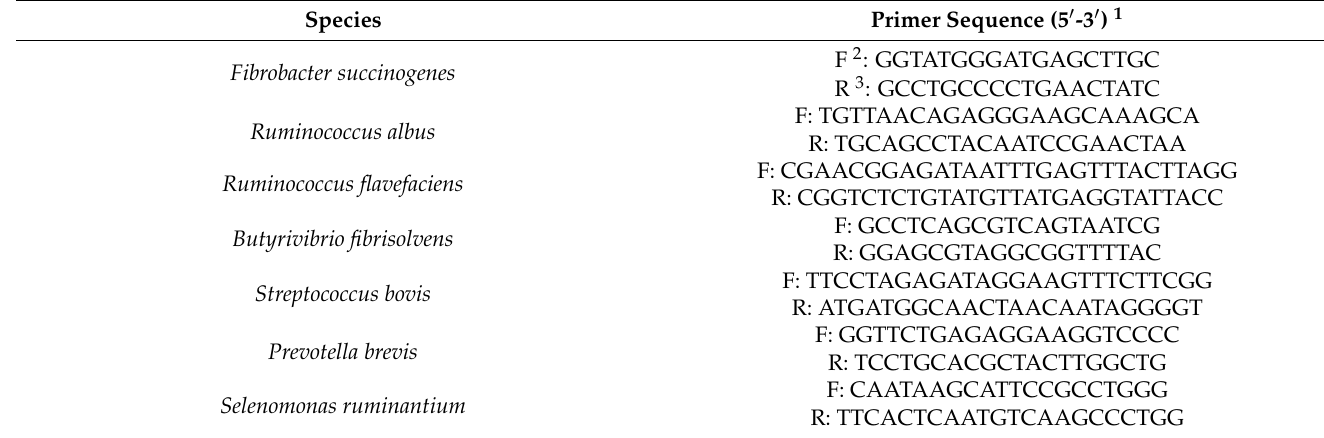
Table 2. Rumen microorganism quantitative real-time PCR amplification